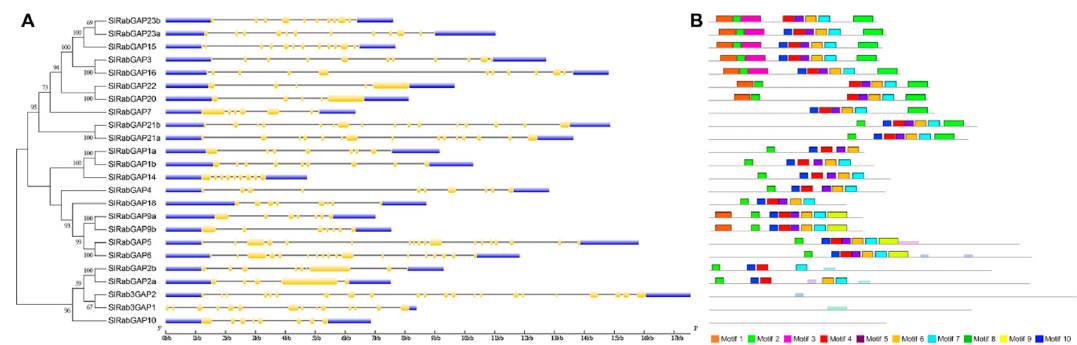
Figure 3. Identification of exon-intron structure and conserved motifs in RabGAP from S. lycopersicum . ( A ). Exon-intron structure of RabGAP genes from S. lycopersicum . In yellow, exons; in blue, the 3 ′ and 5 ′ UTR regions; and the gray lines are introns. ( B ) Conserved motif of RabGAP proteins. Ten motifs were identified with MEME database. The gray lines are the complete amino-acid sequence represented proportionally. Each color represents a different motif. Together, the pink, red, purple, orange, and light blue motifs represent the TBC domain. The consensus sequences are detailed in Table S2.